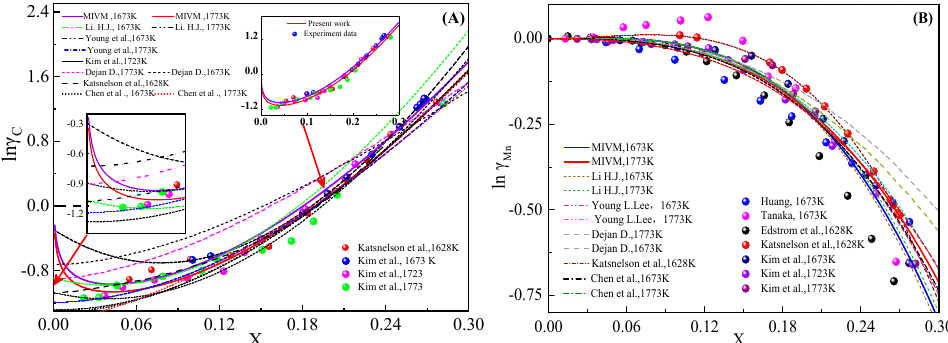
Figure 3. ln γ Mn ( A ) and ln γ C ( B ) vs. X C concentration in Mn-C liquid alloys at 1628 to 1773 K; experimental data are represented by symbols, while solid and dashed lines represent a Mn /a C modeled herein using the MIVM and other models, respectively.